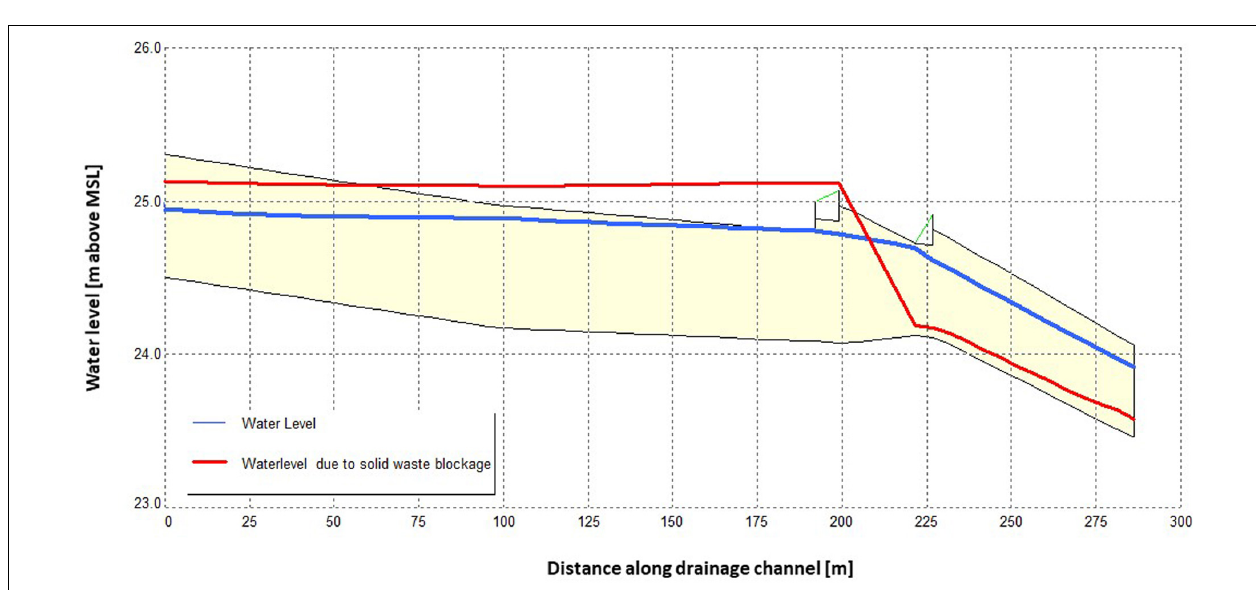
FIGURE 5 | Flow difference and depth difference in drainage channels when blocking a drainage segment.